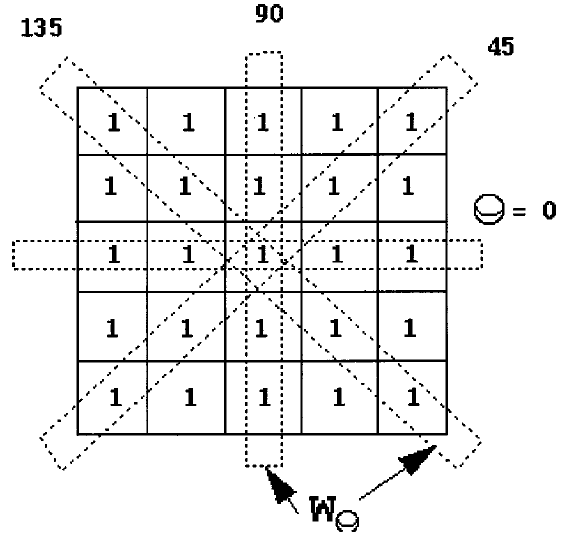
Fig. 3. Directional smoothing